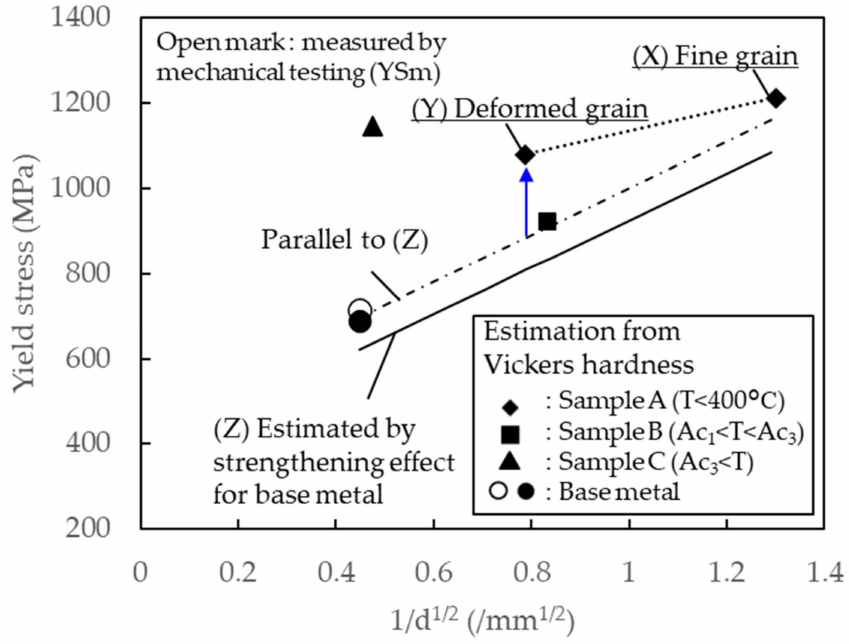
Figure 19. Summary of the local yield stress estimated by the local Vickers microhardness for the BM and samples A, B, and